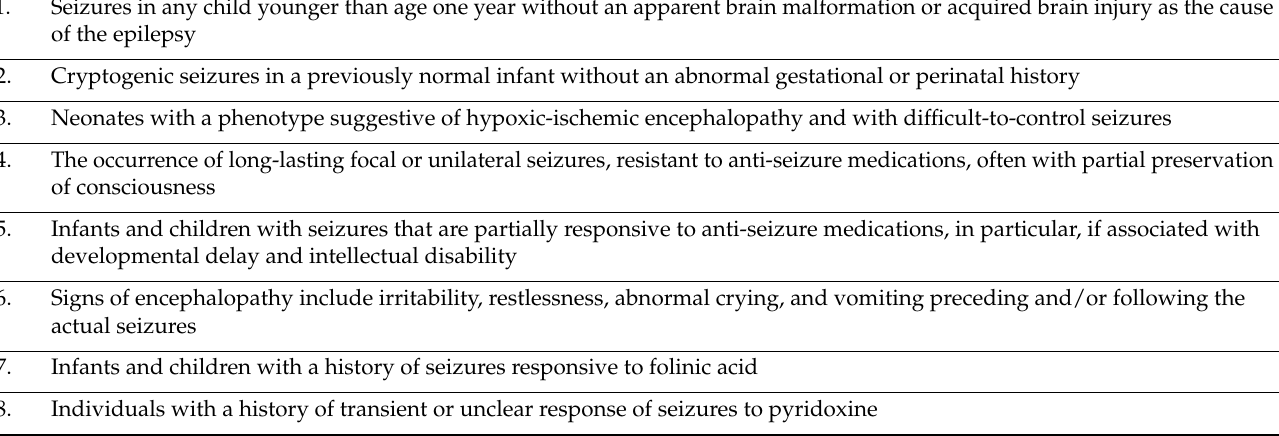
Table 1. Clinical features when PDE should be suspected